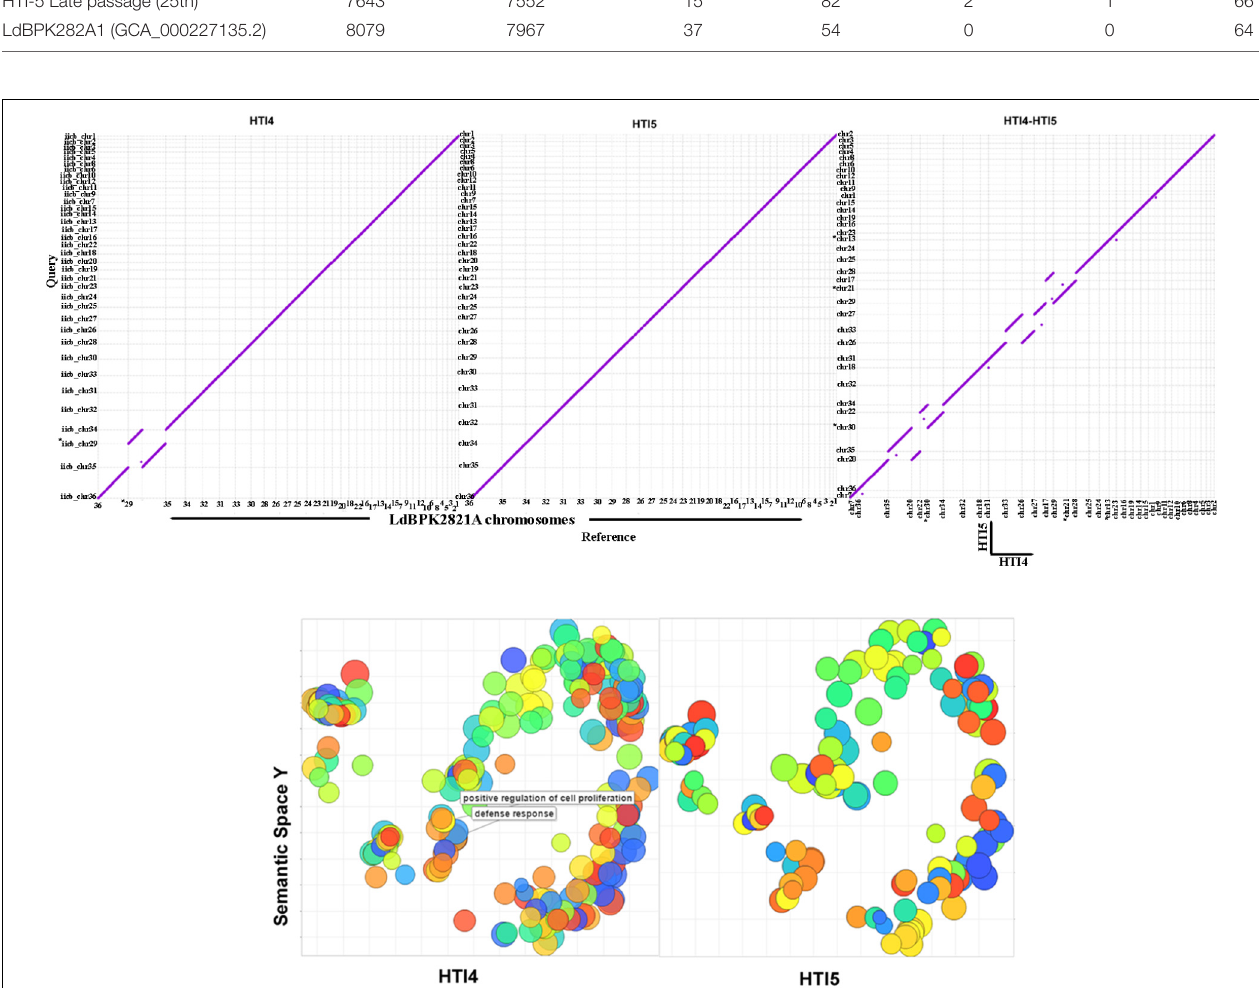
FIGURE 3 | Mummerplot comparisons and Gene Ontology analysis of early and late passage genomes to the NCBI reference genomes. (Upper) The y -axis represents HTI4 (left) or HTI5 (middle) whole genome assemblies compared to x -axis representingLdBPK282A1 assembly. The HTI4 ( x -axis) versus HTI5 ( y -axis) chromosomal assembly comparison is given in the right panel. The dots represent the positions of conserved DNA sequences on the genomes. (Lower) REVIGO was used to visualize the summary of significantly enriched GO terms. The scatterplots show the cluster representatives in a two dimensional space derived by applying multidimensional scaling to a matrix of the GO terms’ semantic similarities for early (left panel) and late (right panel) passages. Clustal differences are represented in boxes. Bubble color indicates the user-provided p -value; size indicates the frequency of the GO term in the underlying GOA database (bubbles of more general terms are